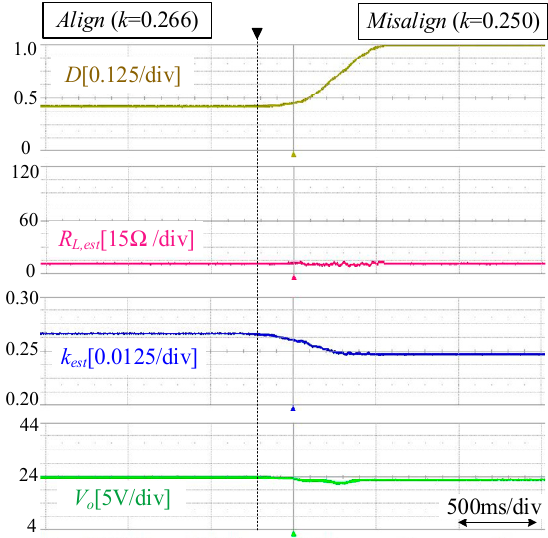
Figure 11. Waveforms of the switching duty cycle ( D ), estimated resistance ( R L,est ), estimated coupling coefficient ( k est ), and output voltage ( V o ), where the coupling coefficient varied from 0.266 to 0.250.